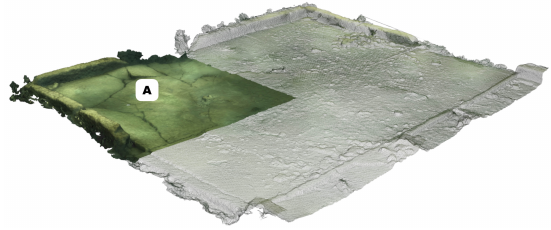
Figure 6. South-west Corner of The Cambell’s